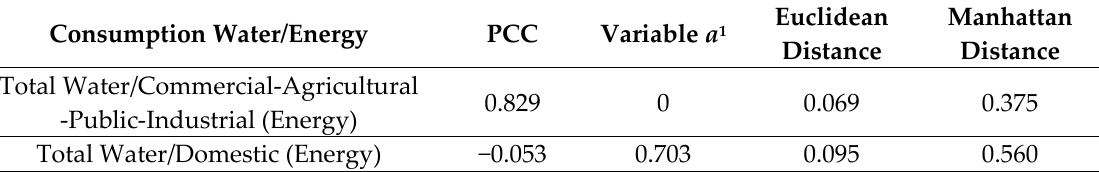
Figure 3. The PCC graphs between water and energy consumption (normalized values): ( a ) PCC graph for total water and for 4 uses of energy consumption (agricultural, commercial, industrial and public); ( b ) PCC graph for total water and domestic use of energy consumption. Table 2. Values of PCC, Euclidean and Manhattan